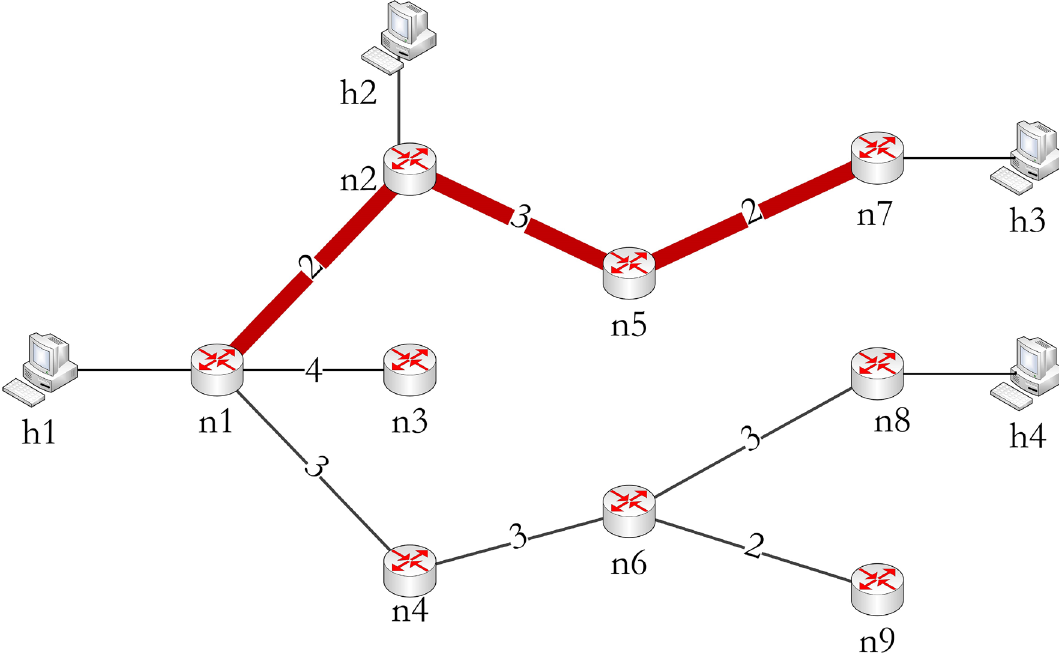
Figure 2. Shortest path tree and trunk selection.